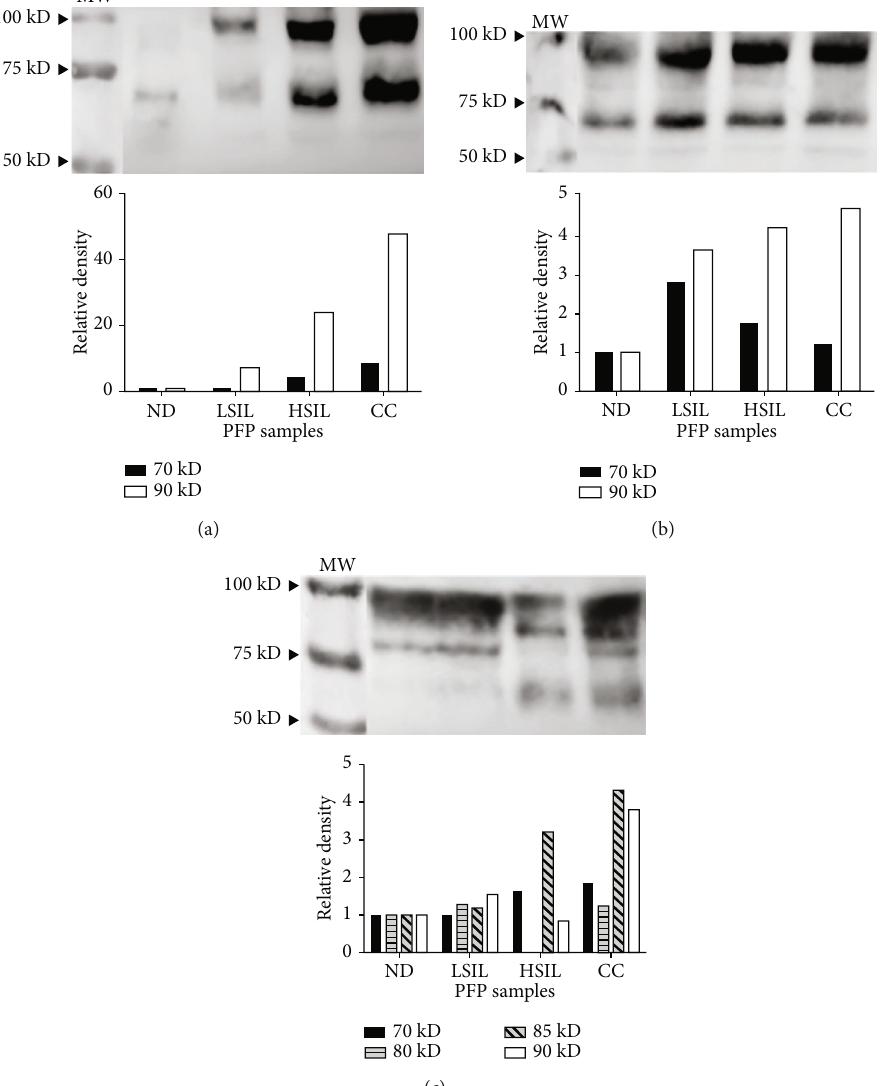
Figure 4: Detection of CD73 in the PFP of NDs and patients with LSILs, HSILs, or CC. Samples of 3 μ l of PFP (a) or 20 ng of CD73 contained in the PFP (b) of the ND, LSIL, HSIL, and CC groups were analyzed by Western blot using the anti-CD73 antibody. The densities of the 70kD (black bars) and 90kD (white bars) bands detected in the samples of patients with LSILs, HSILs, or CC relative to those of NDs (set to 1) are shown. (c) Twenty-nanogram samples of CD73 contained in PFP were subjected to deglycosylation using the enzymes endoglycosidase H and N-glycanase. The densities of the 70kD (black bars), 80 kD (bars with horizontal lines), 85 kD (bars with diagonals), and 90 kD (white bars) bands detected in the LSIL, HSIL, and CC samples relative to the ND samples (set to 1) are shown. MW: molecular weight. A representative test of three independent tests is